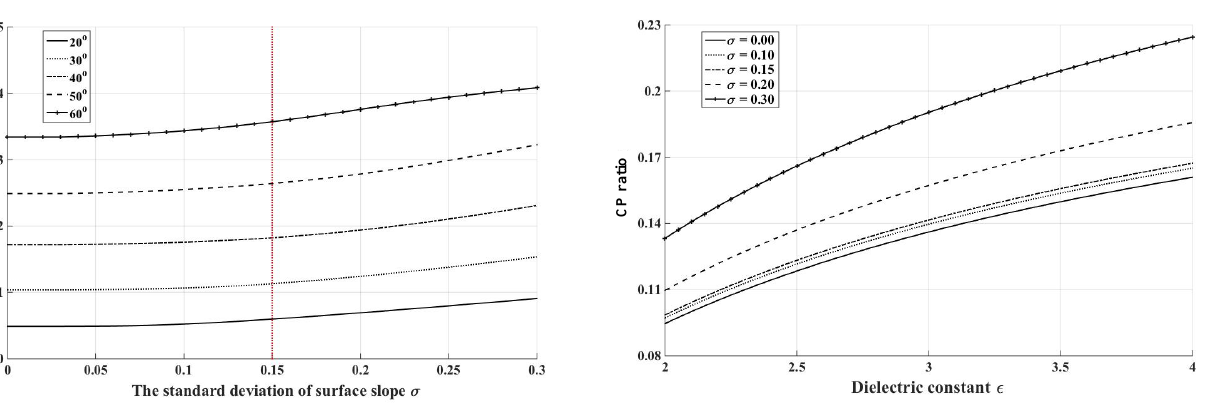
Figure 2. CP ratio as a function of dielectric constants for differ- ent σ and incidence angle = 30 ◦ . The results for other incidence angles follow the similar